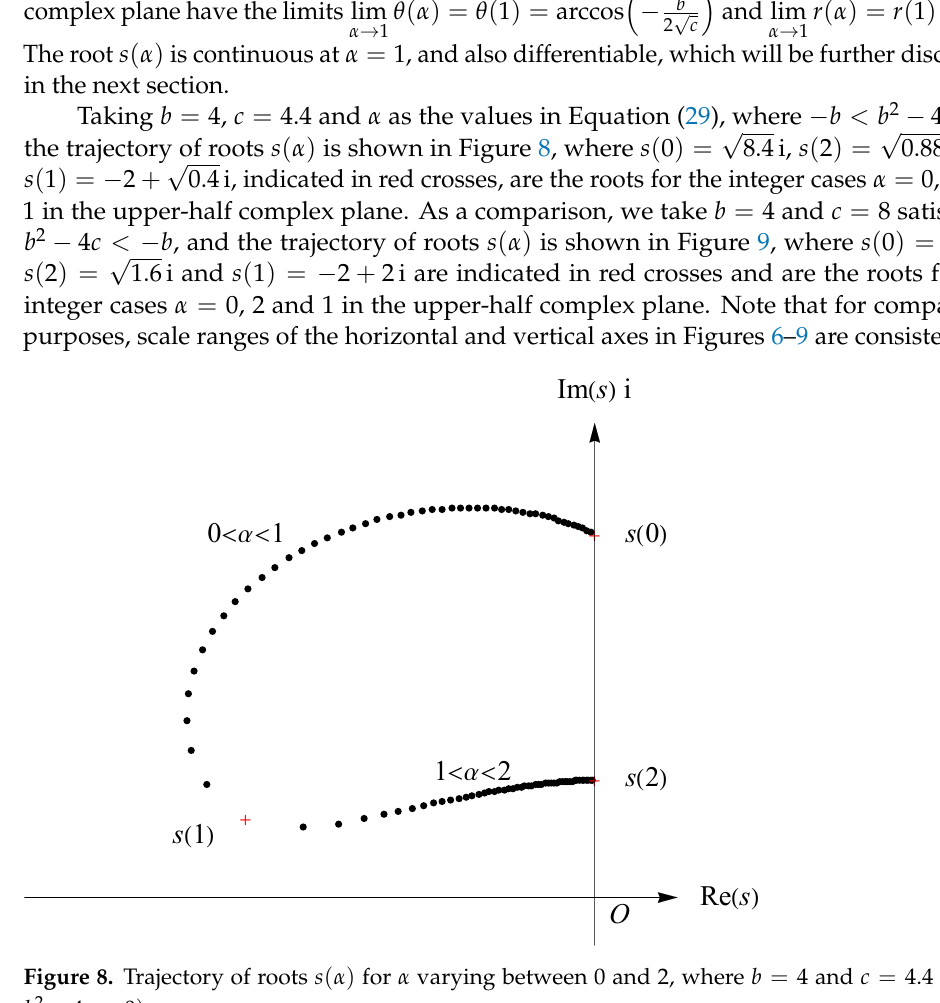
Figure 8. Trajectory of roots s ( α ) for α varying between 0 and 2, where b = 4 and c = 4.4 ( − b < b 2 − 4 c < 0 )